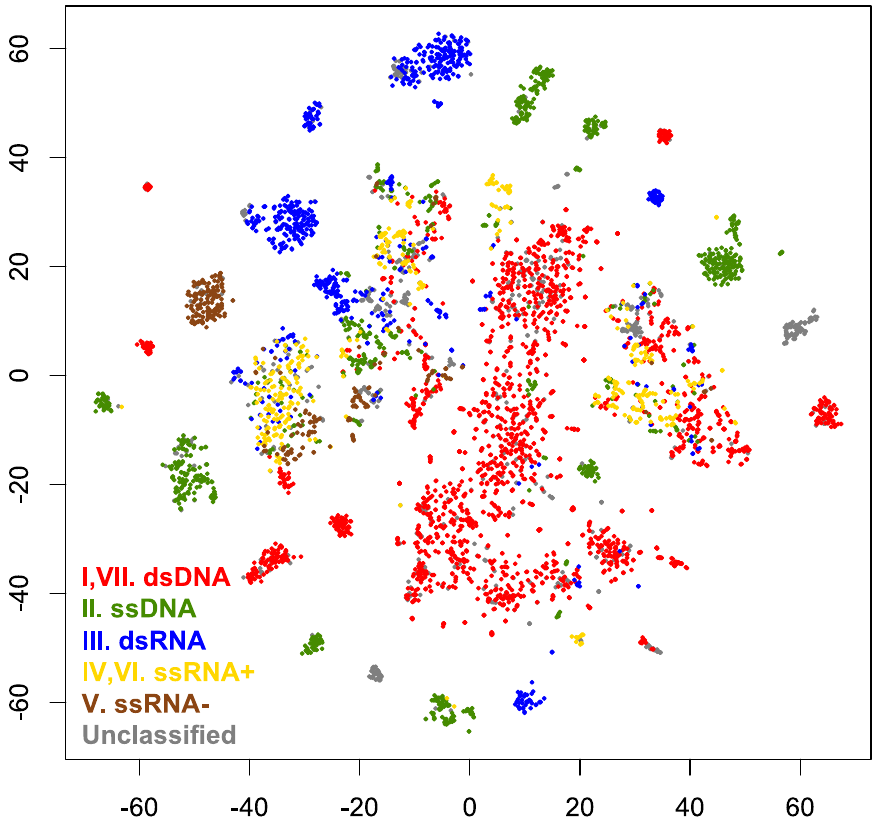
Fig 3. t-SNE plot of 5,817 viruses from RefSeq, grouped by mutual information of genes in common and 4-mer frequency. Points are colored by Baltimore classification: red = dsDNA viruses (Baltimore class I & VII), green = ssDNA viruses (Baltimore class II), blue = dsRNA viruses (Baltimore class III), yellow = ssRNA viruses, positive sense (Baltimore class IV & VI), brown = ssRNA viruses, negative sense (Baltimore class V), and gray = unclassified.